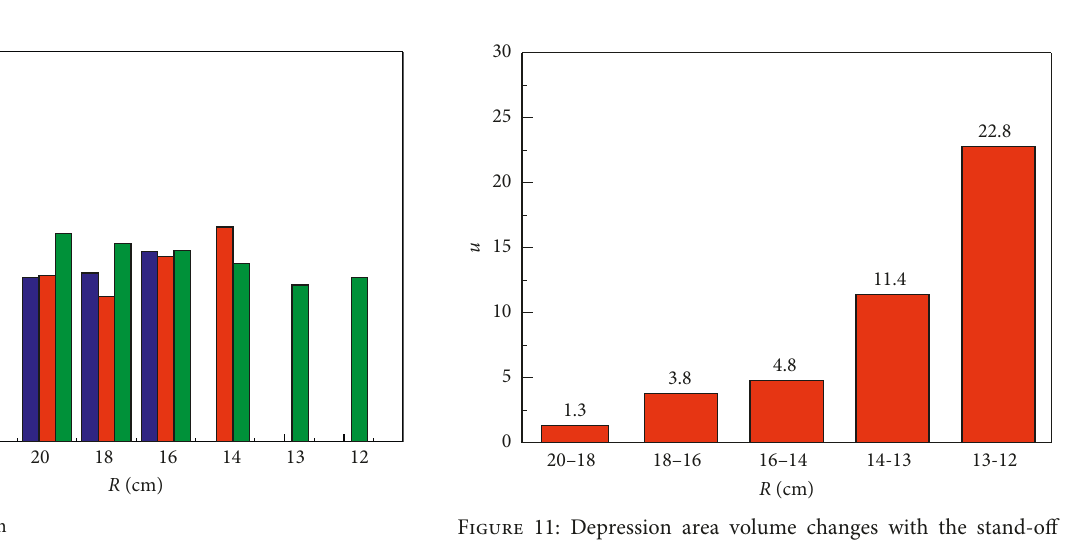
Figure 9: The failure grade of square tubes under single and double explosions. (a) Failure grade under single explosion. (b) Failure grade under double explosion.